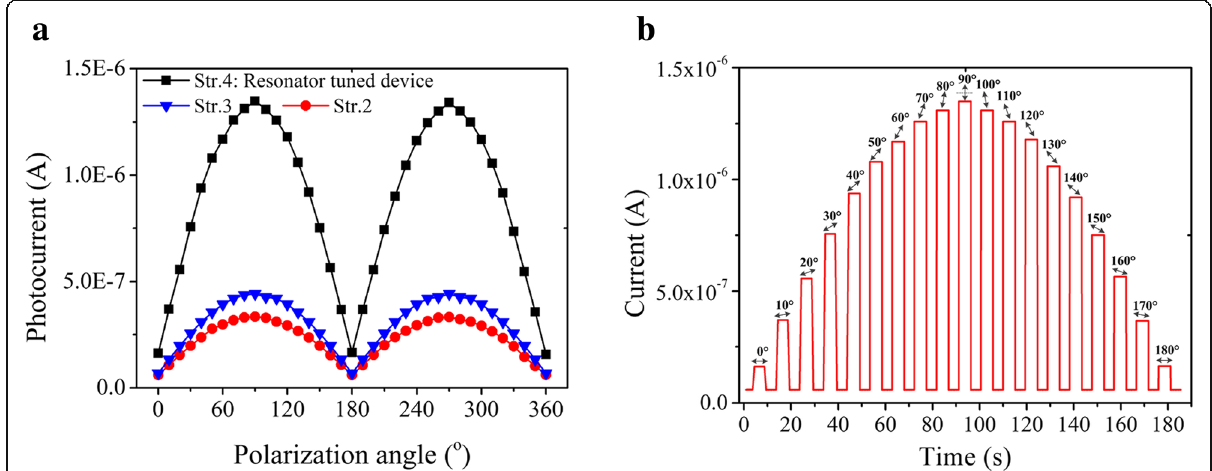
Fig. 7 Experimental demonstration of polarimetric detection by the fabricated all-Si photodetector. a Polarization dependence of the photo- electon current. b Photocurrent response of resonator tuned MS detector under the 16.6 mW/cm 2 incident light with different polarization angles measured at the DC bias of − 2 V. The polarization angle was marked with a black arrow onto its corresponding